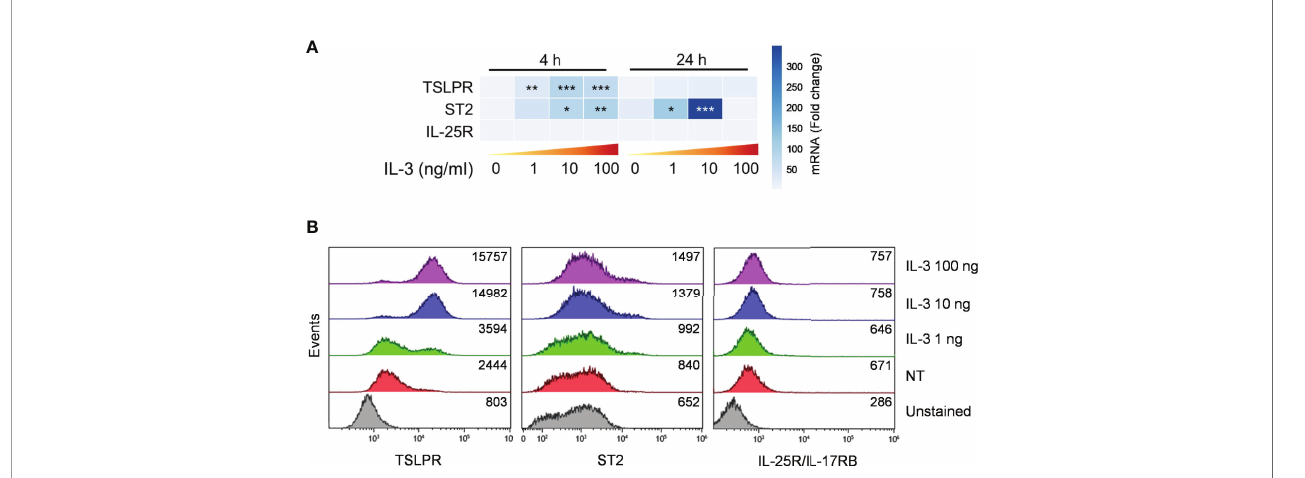
FIGURE 5 | Expression of alarmin receptors by murine basophils. Sorted mBaso (10 6 cells/ml) were cultured (24 hours at 37°C) alone (NT) or in the presence of the indicated concentrations of rmIL-3. Cells were then analyzed for expression of ST2, TSLPR and IL-25/IL-17RG by (A) qRT-PCR and (B) fl ow citometry. (A) Data in heatmap represent the mean fold mRNA increase normalized to HPRT and with respect to untreated (0) controls at 4 h +/- SD. (B) Numbers inside each plot represent mean fl uorescence intensity values. One representative experiment out of two is shown. * p < 0.05; ** p < 0.01; *** p <